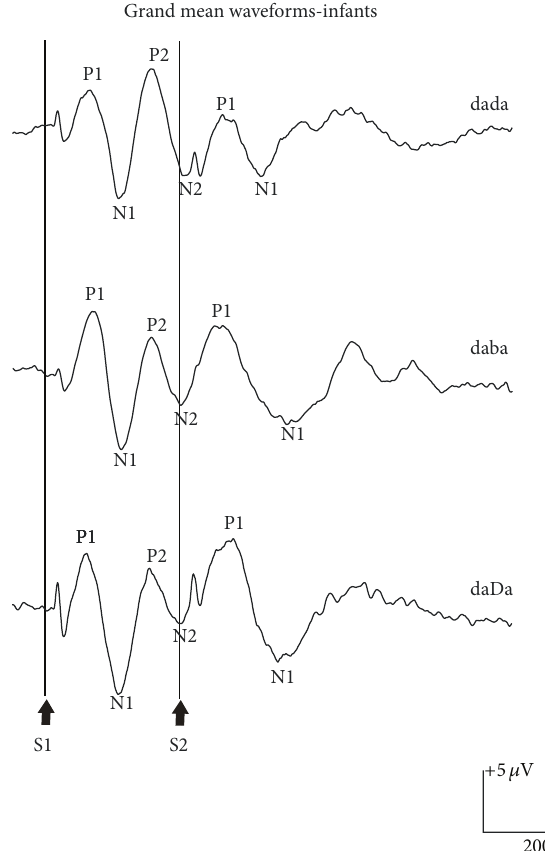
Figure 4: Grand mean waveform elicited to /dada/, /daba/, and /daDa/ at C3 for a total of 24 English-speaking 4-month-old infant participants with normal hearing. The onset of the S1 and S2 portion of the S1S2 stimuli is shown at the bottom of the graph. The P1, N1, P2, and N2 components of the obligatory cortical response elicited to S1 are indicated on the